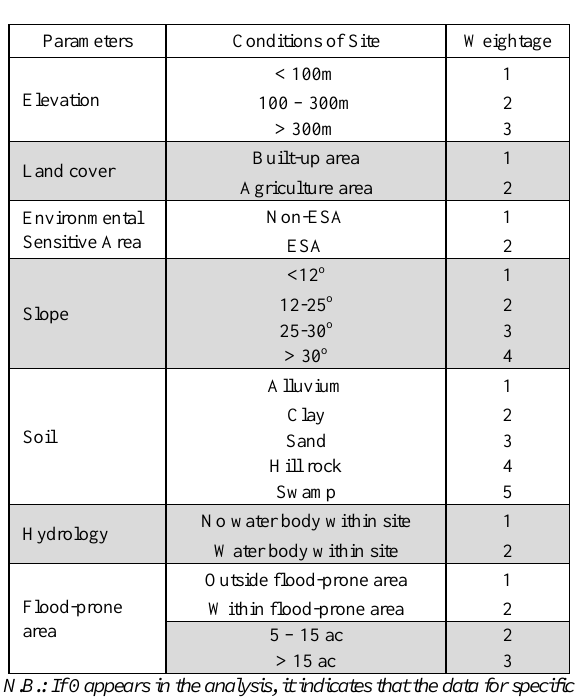
Table 3: Weighted parameters for the e-DIA environmental impact